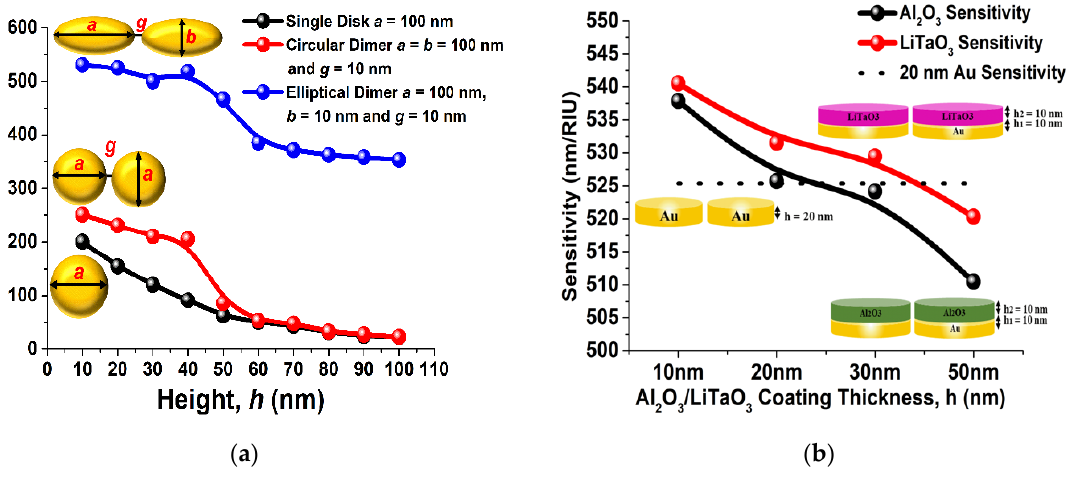
Figure 2. ( a ) The performance of the single, coupled circular and coupled elliptical shaped gold nano antenna array [66] ( b ) The sensitivity performance of the two-layer hybrid nanoantenna